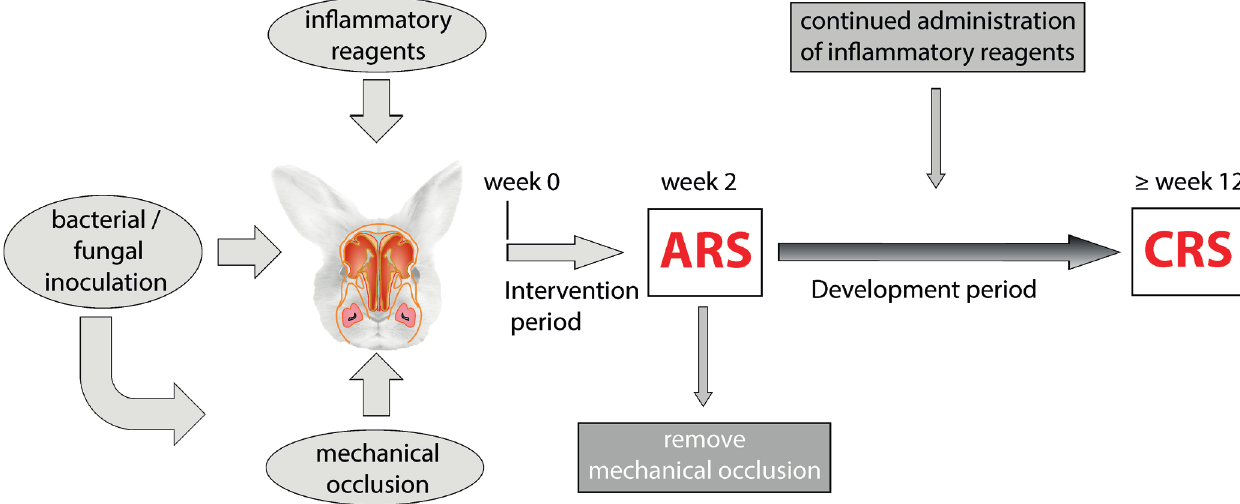
Figure 2. Experimental techniques for the development of acute rhinosinusitis (ARS) and CRS in animal models. Rabbit’s sinus anatomy is shown. Methods can be used alone or in combination. Grey arrows indicate how each method can be applied to induce acute or chronic sinonasal inflamma- tion. Bacterial or fungal inoculation is most commonly applied in combination with mechanical occlusion (curved arrow). A two week intervention period is shown as